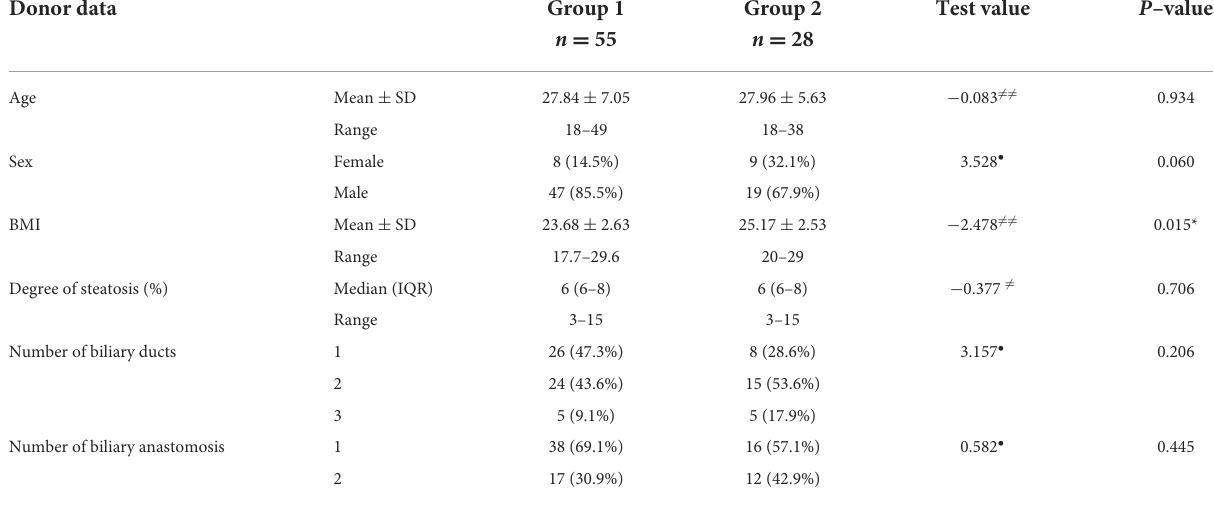
TABLE 3 Donor characteristics in the study groups.